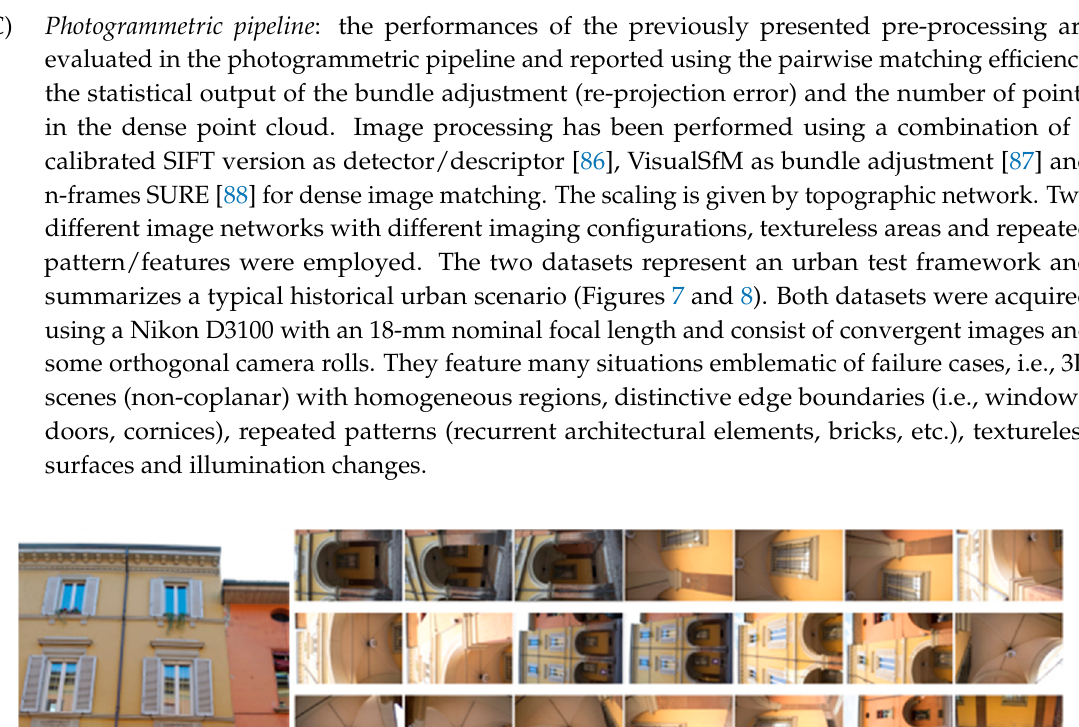
Figure 8. The Palazzo Albergati dataset. The first dataset (building with portico/35 images) pertains two spans of a three-storey building (6 × 11 m) characterized by arches, pillars/columns, cross vaults and plastered walls (Figure 7). Camera moved along the porticoes, with some closer shots of the columns. The second dataset (Palazzo Albergati/39 images) depict a three-storey historical palace (54 × 19 m) characterized by repeated brick walls, stone cornices and a flat façade (Figure 8). Camera moved along the façade of the building, with some closer shots of the entrances. ( a ) ( d ) Figure 9. Results of SIFT interest point detection using different color enhancements: ( a ) no enhancement; ( b ) manually enhanced; ( c ) automatically enhanced; ( d ) automatically enhanced using the whole pipeline (polynomial regression + ACR based correction). Although in ( d ) the number of detected points is lower, they are more robust and reliable, allowing better orientation procedures.